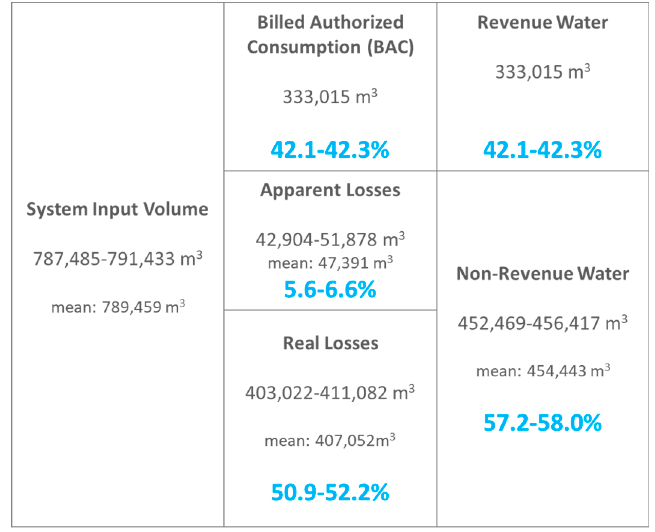
Figure 15. Seasonal high-level component analysis of SIV into billed authorized consumption (BAC), apparent losses, real losses, revenue water and nonrevenue water (all components are also presented as percentages of SIV).